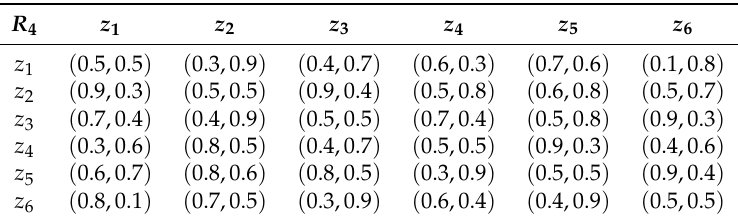
Table 4. PFPR of the third stock